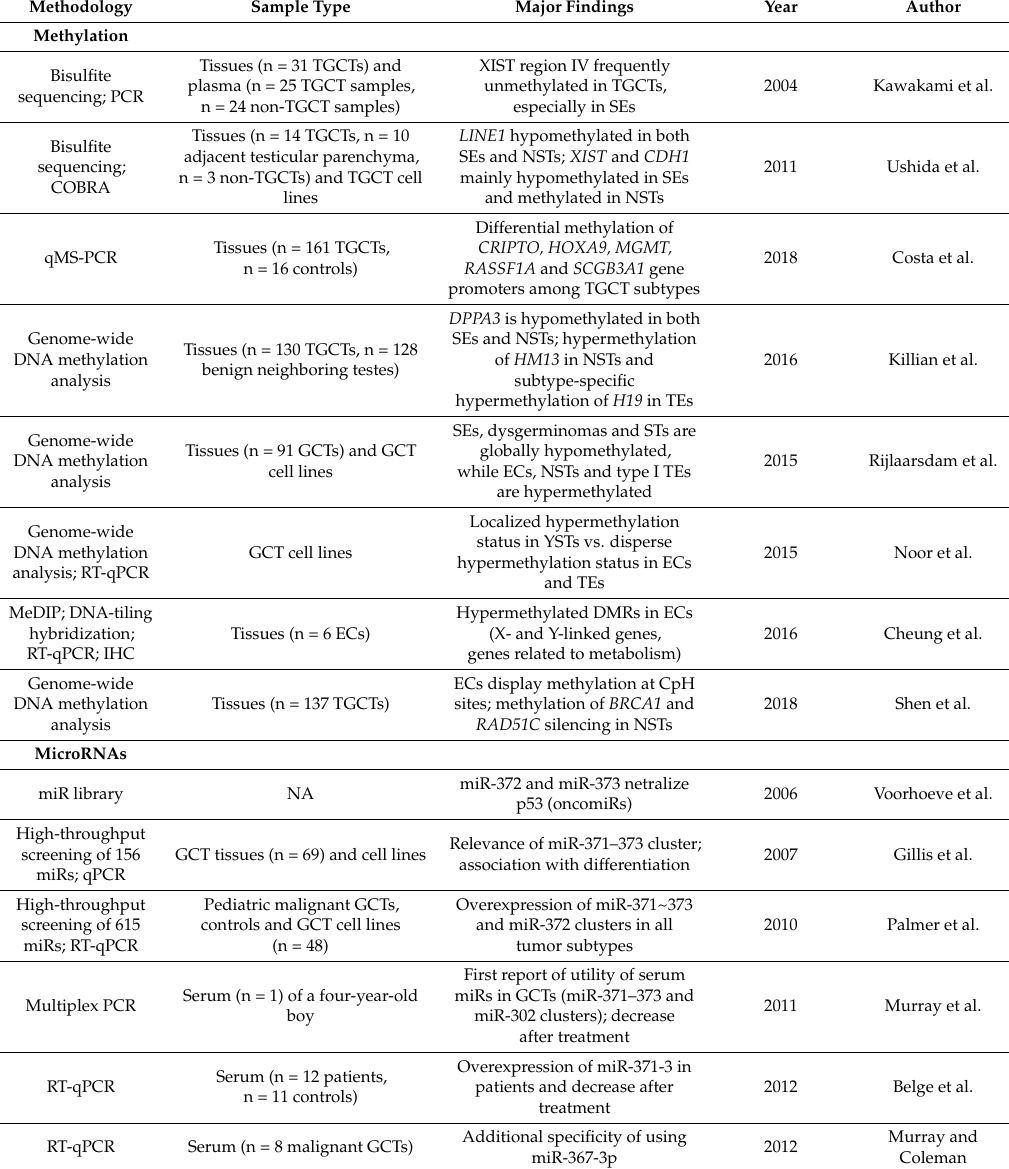
Table 4. Summary of studies on testicular germ cell tumor biomarkers regarding methylation and